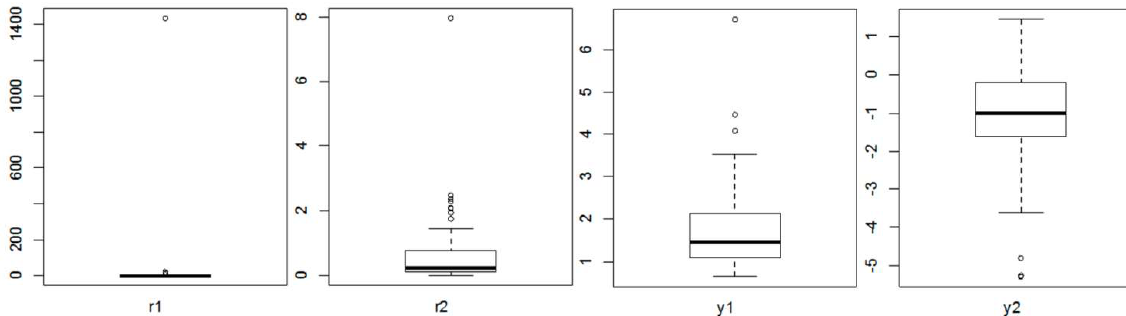
Figure 7. Box plots of standard ( r 1 , r 2 ) and compositional ( y 1 , y 2 ) financial ratios.